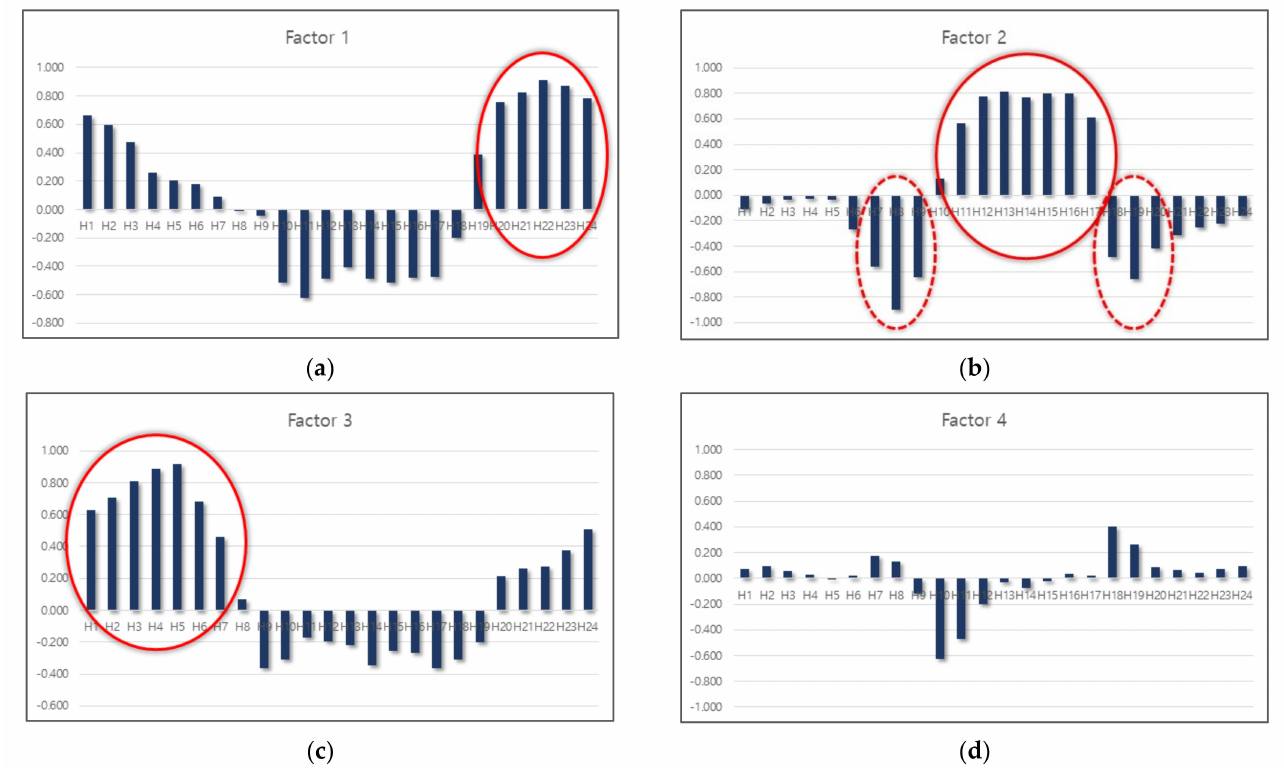
Figure 5. Hours with high factor loadings: ( a ) Factor 1; ( b ) factor 2; ( c ) factor 3; ( d ) factor